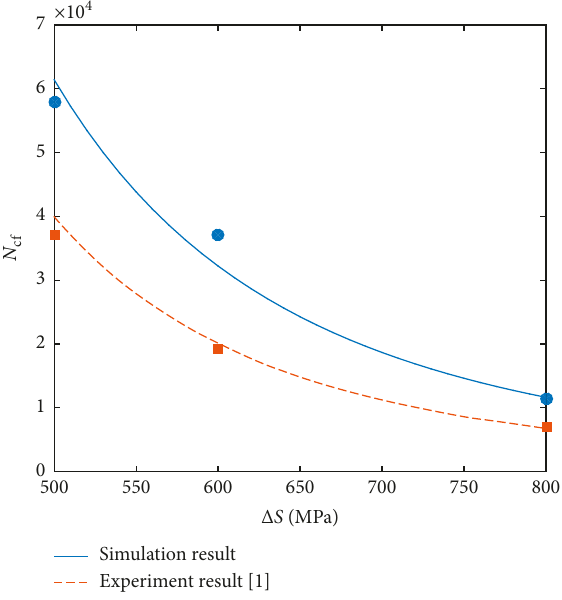
Figure 16: CF S-N curves of steel wires obtained from simulation and experiment.